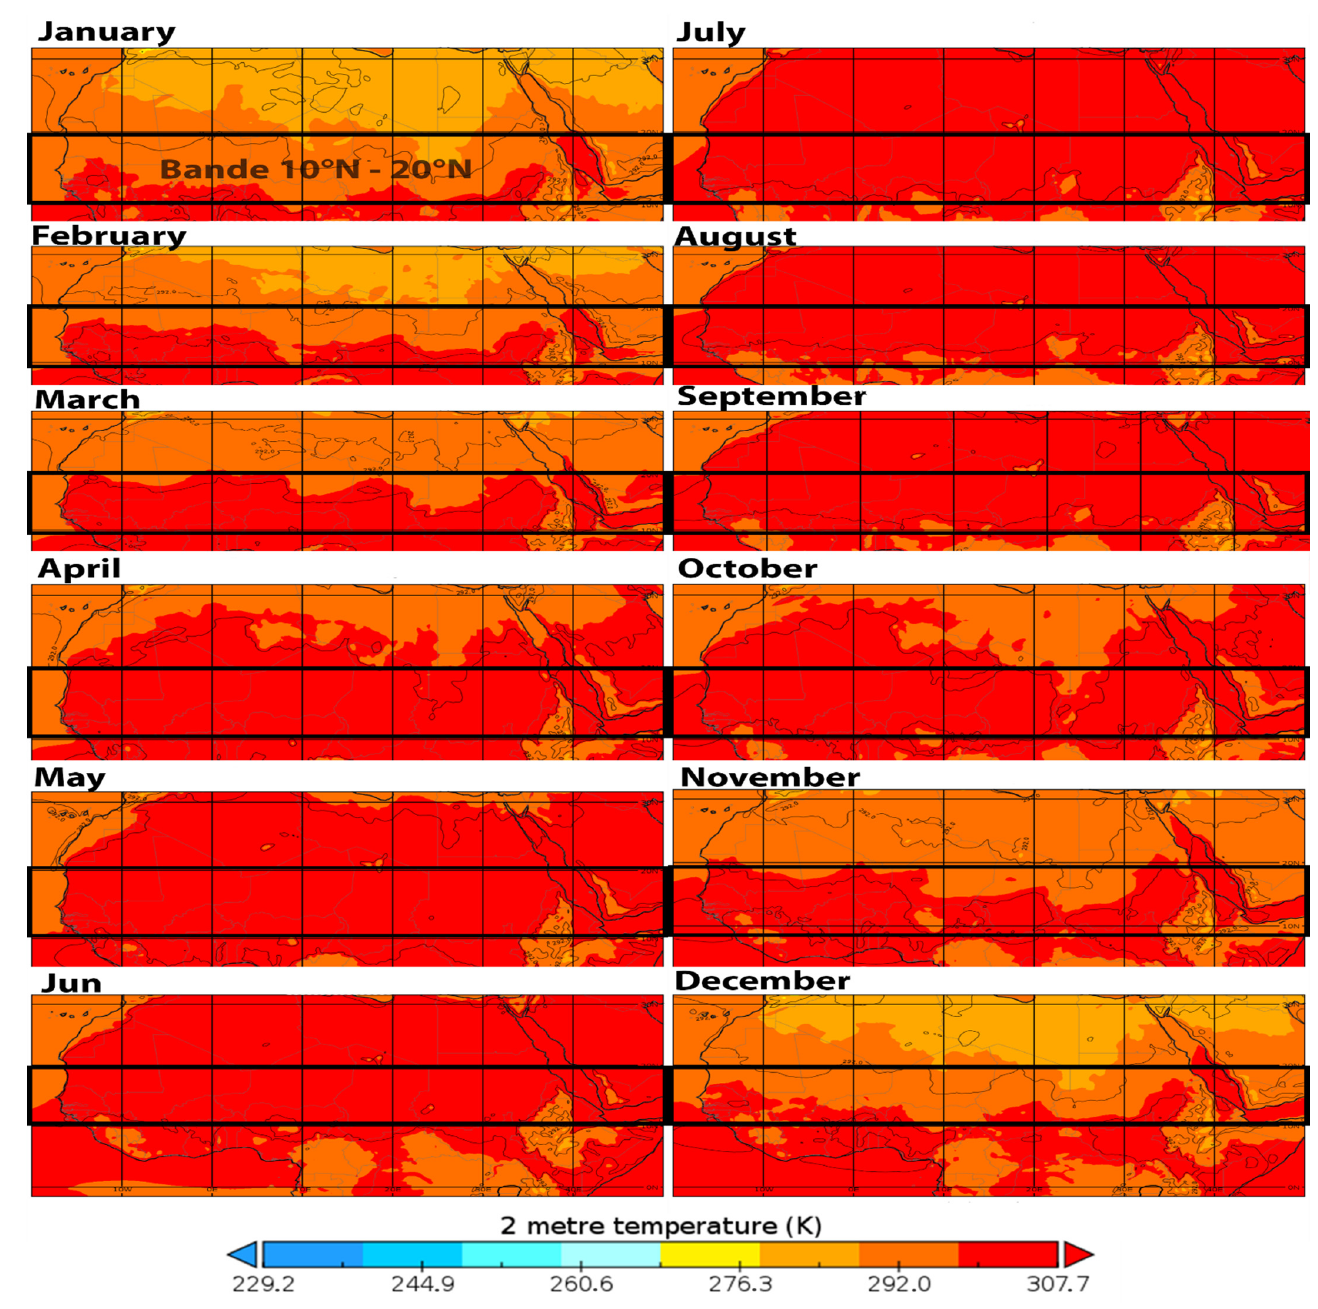
Figure 2. Climatology in monthly mean 2 meter temperature (4D-Var ERA5) ◦ Kelvin from 1979 to 2008 with a resolution of 0.5 × 0.5 degrees. Data from the ERA5 platform.